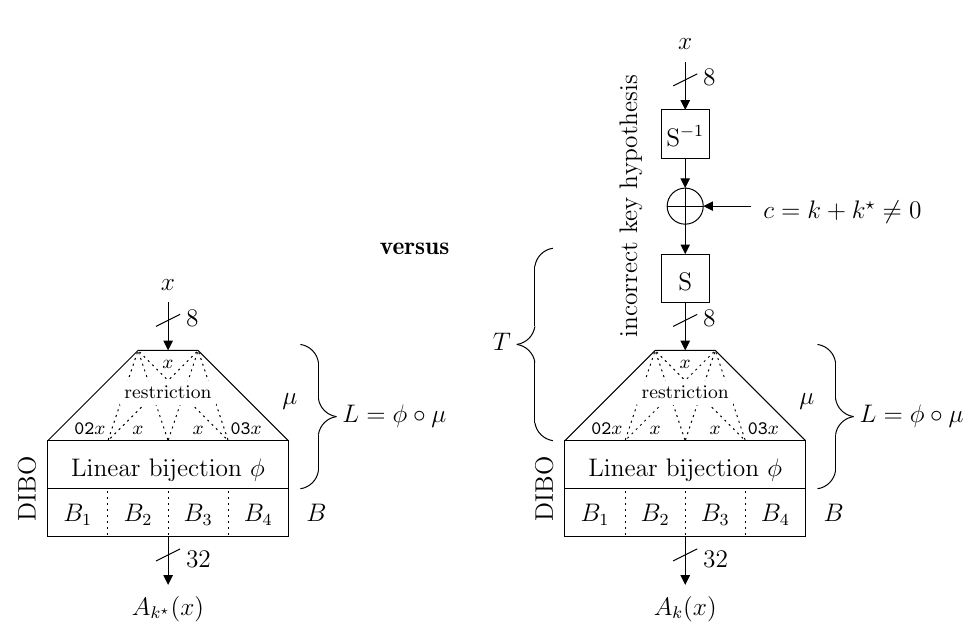
Figure 2: Two WBC situations to be distinguished, cases A k ? and A k , for k 6 = k ?